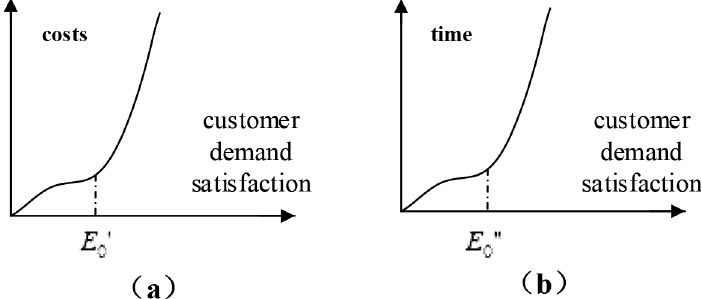
Figure 3. Relationship in customer demand satisfaction, development time and